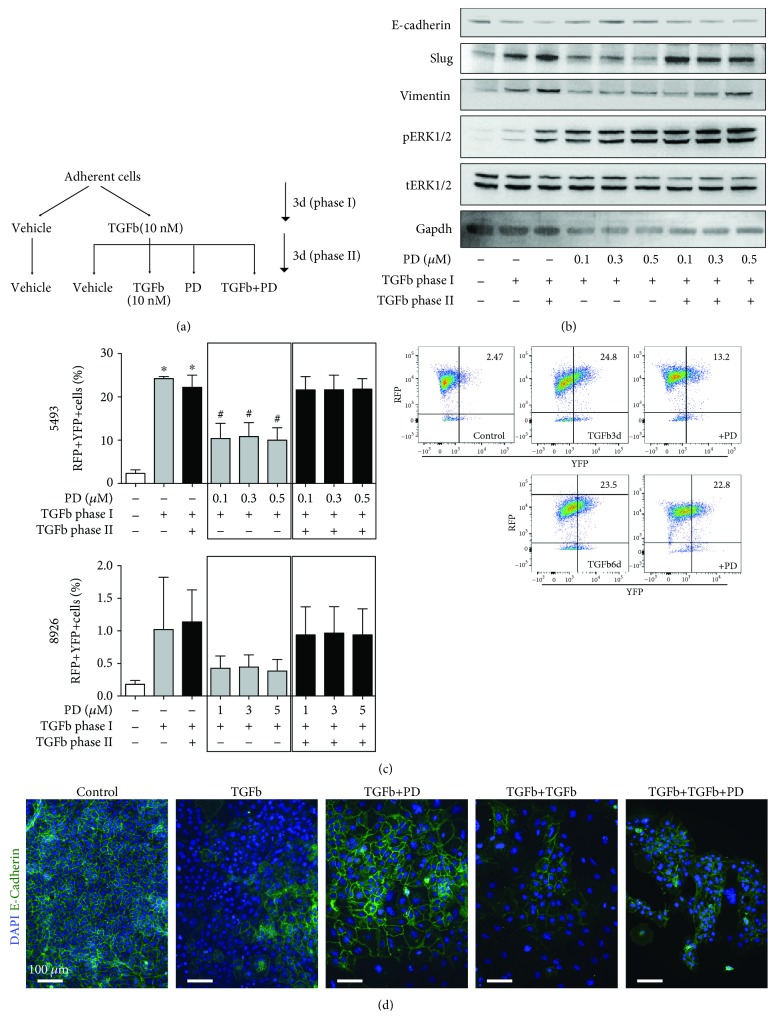
Effects of MEK inhibition on TGFβ-induced EMT. (a) Experimental overview for TGFβ and PD0325901 co–treatment. (b) Western blot analysis of key proteins involved in EMT with treatment in vitro. Gapdh was used as a loading control. (c) Percentage of RFP+YFP+ cells under treatment as indicated and representative cytometry blots. (d) Immunofluorescence micrographs of E-cadherin expression with treatment as indicated. n ≥ 3 for all experiments, n ≥ 2 for Western blots. ∗
P < 0.05 vs. control, #
P < 0.05 vs. TGFβ.